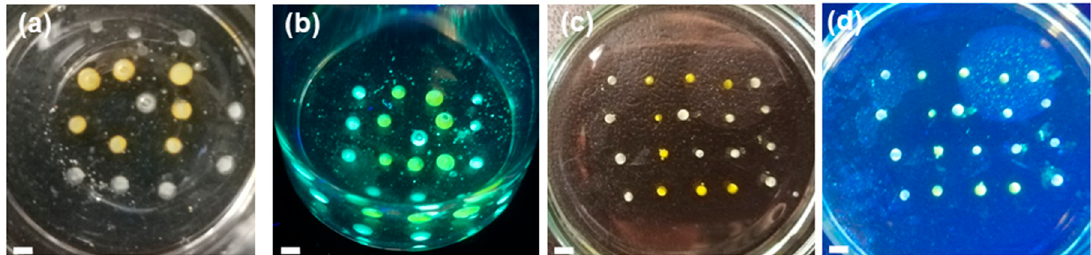
Figure 5. ( a ) Digital and ( b ) fluorescent images of colored pattern with CN / TCM and CN-F / TCM in aqueous PEI solution; ( c ) Digital and ( d ) fluorescent images of colored ‘c’ pattern with CN-A / TCM and CN-F / TCM in aqueous PEI solution. Scale bars correspond to 1 cm.